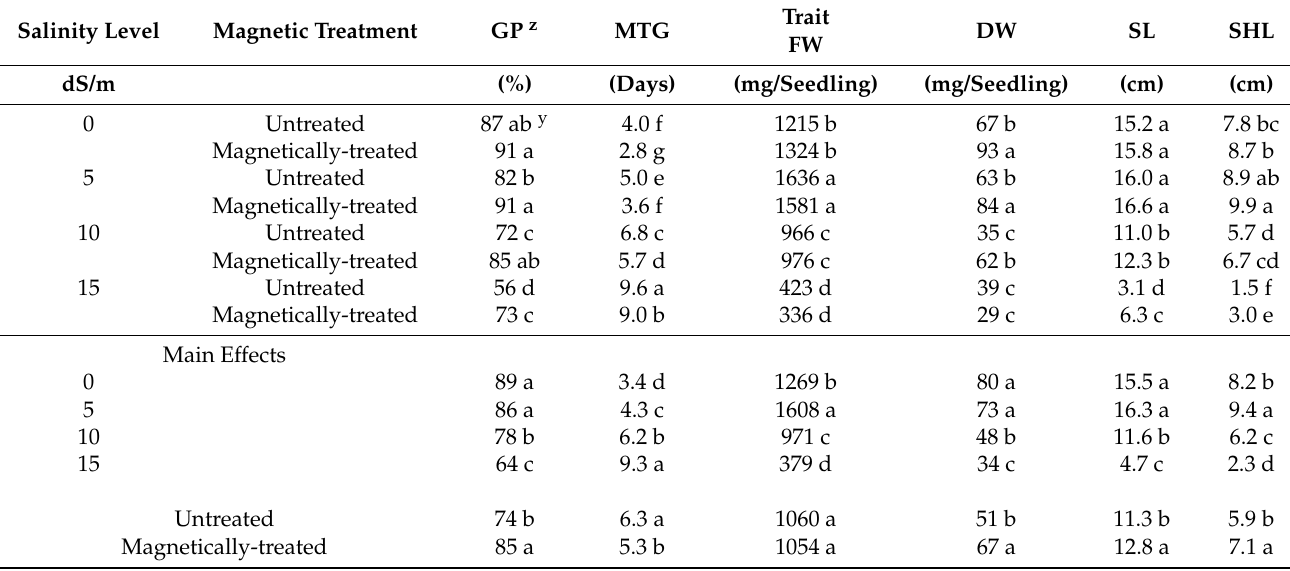
Table 2. Seed germination percentage, mean time to germination, seedling fresh weight, seedling dry weight, seedling length, and shoot length in a standard germination test at 25 ◦ C of magnetically-treated tomato seeds watered with different levels of